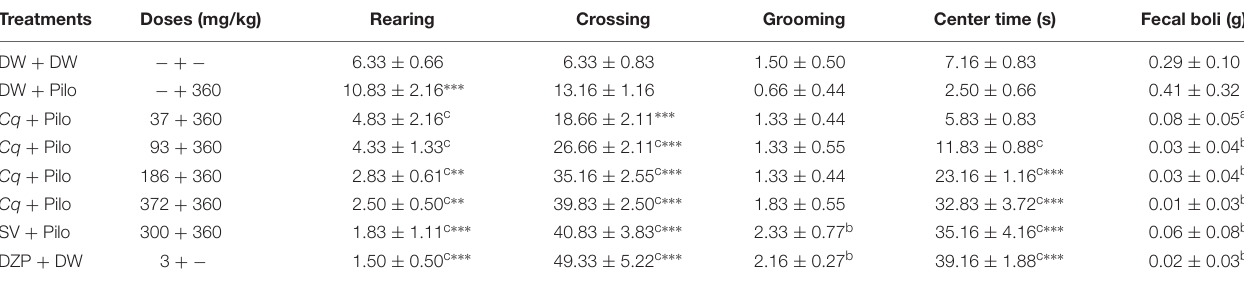
TABLE 2 | Effect of C. quadrangularis in open field test: rearing, crossing, grooming, center time, and quantity of fecal boli. Treatments Doses (mg/kg) Rearing